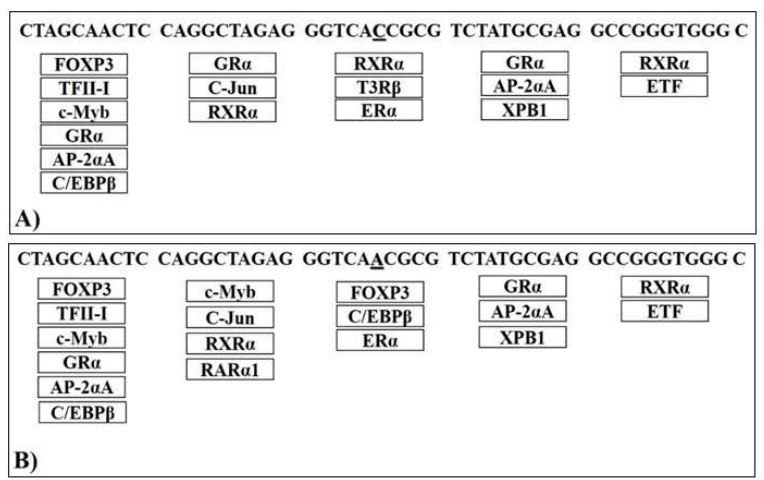
Fig. 2. A putative pattern of transcription factor binding site near the -160 polymorphic site of the CDH1 promoter: The polymorphic nucleotide is shown as underline; A ) The C allele; and B ) the A